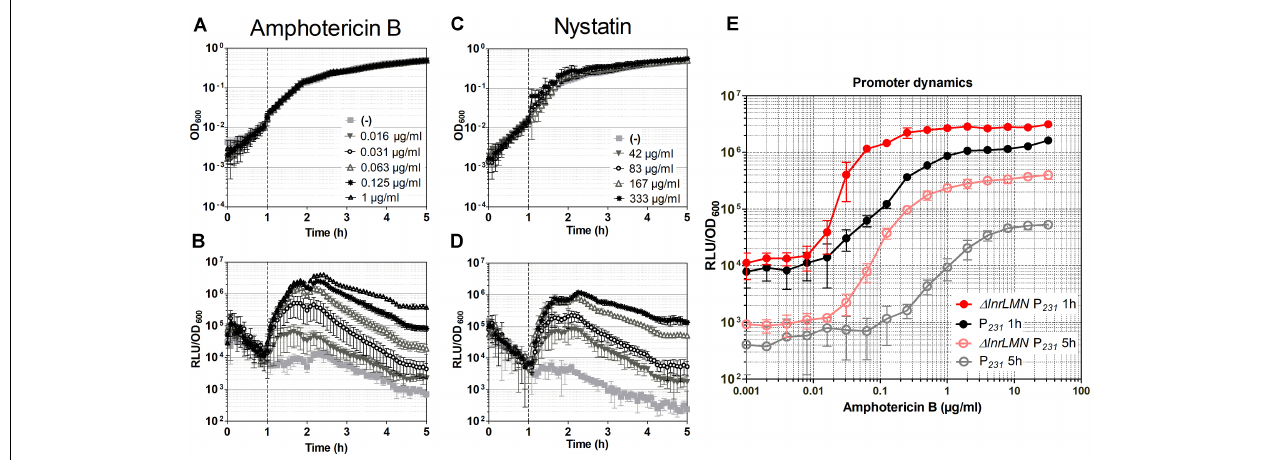
FIGURE 5 | Characterization of the (cid:49) lnrLMN P lnrL 231 - lux (TMB5600) whole-cell biosensor. (A–D) Induction of the (cid:49) lnrLMN P lnrL 231 (TMB5600) by amphotericin B and nystatin in liquid media. The effect of antibiotic exposure on growth is indicated as OD 600 (A) and (C) ; the promoter induction is presented as relative luminescence units by OD 600 (B) and (D) . The time of antibiotic addition is indicated with a vertical black dashed line. The antibiotic concentrations used are indicated in the upper panels. (E) Effect of deletion of lnrLMN genes on P lnrL 231 promoter dynamics. The amphotericin B-concentration dependent promoter induction when the LnrLMN transporter is present (P 231 , strain TMB4223) or absent ( (cid:49) lnrLMN P 231 , strain TMB5600) on the cell is presented. The values correspond to promoter activities one and five hours after induction with serial dilutions of amphotericin B. The symbols color code is indicated in the graph. The experiments were performed at least in triplicate with two independent clones. Means and standard deviations are